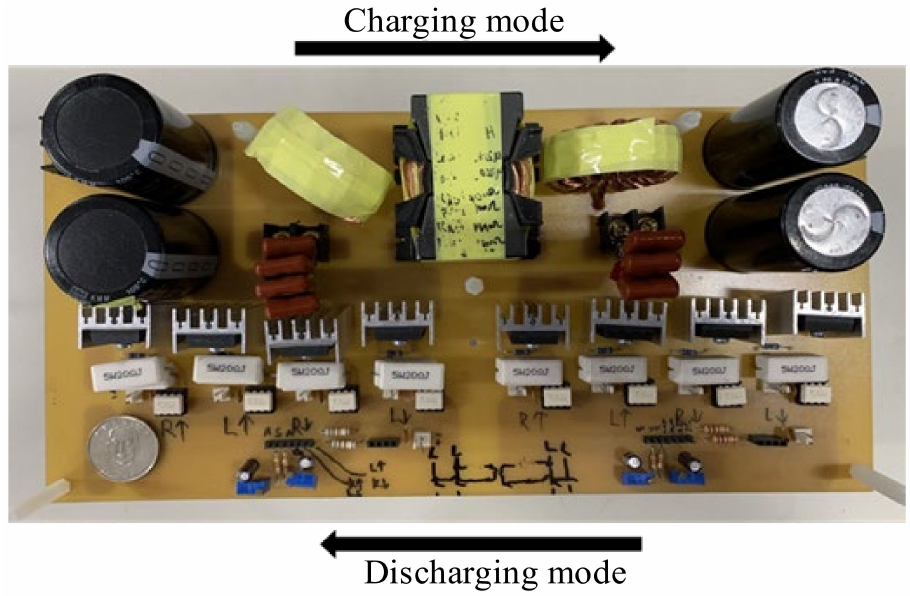
Figure 25. The prototype of the proposed